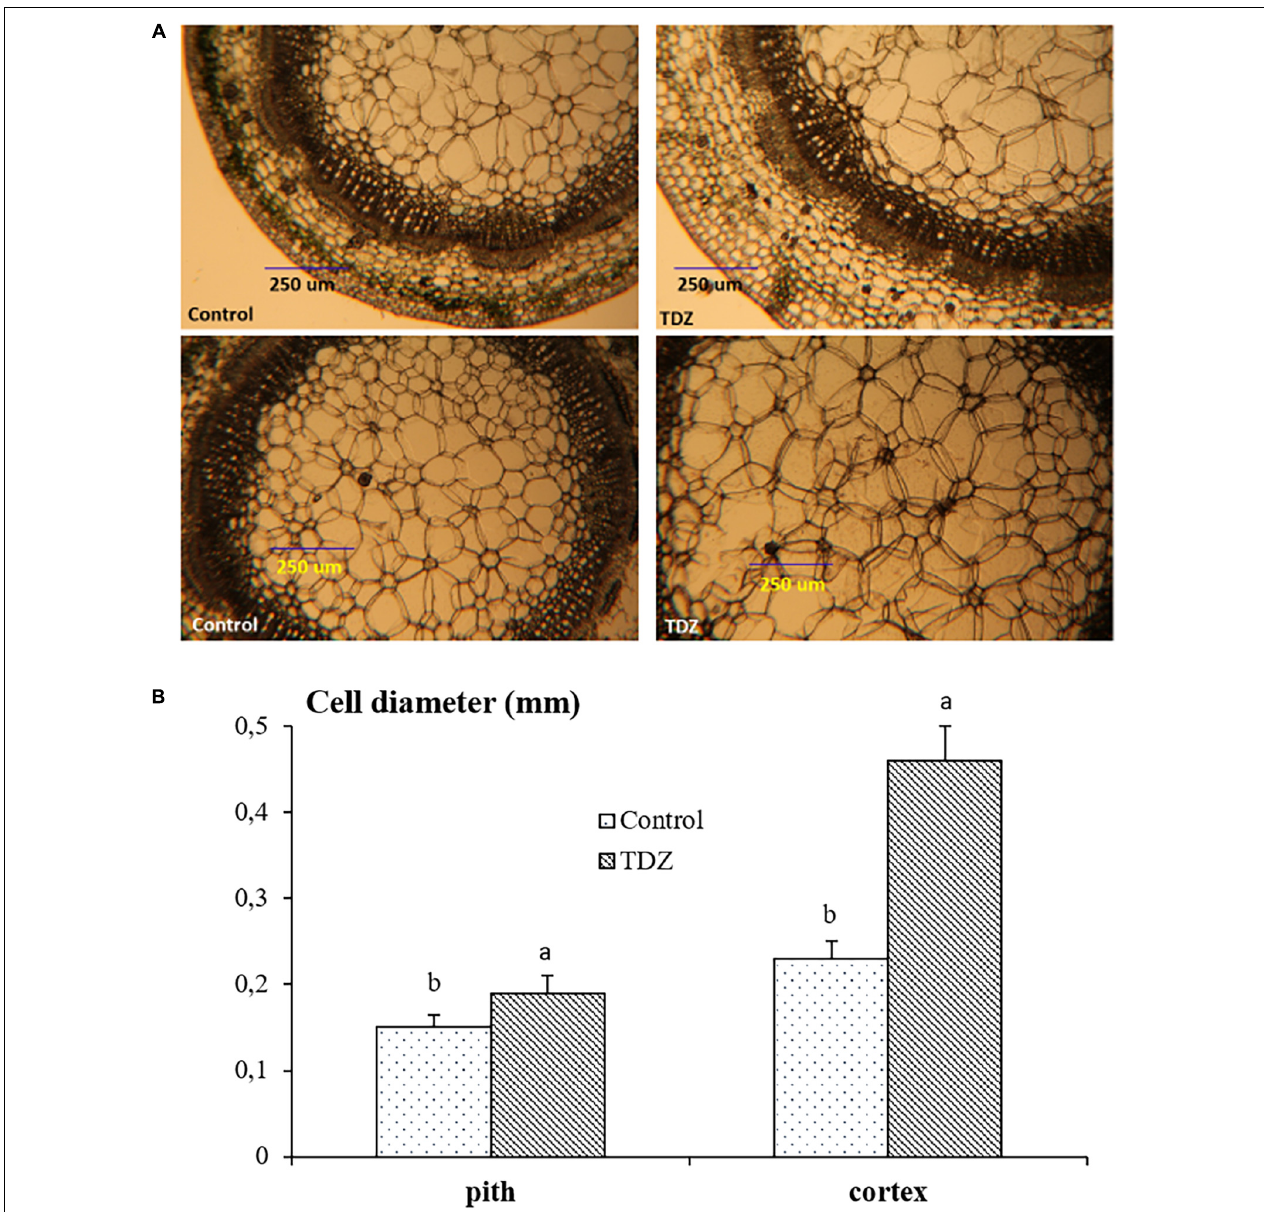
FIGURE 4 | Representative hand-cut transverse sections (A) and mean diameters of pith and cortex cells (B) of third internode after 15 days of treatment with 100 µ M TDZ. The data were taken around the middle sections randomly. Scale bar = 0.25 mm. Means ( ± SE, n = 16) with different letters are significantly different at P ≤